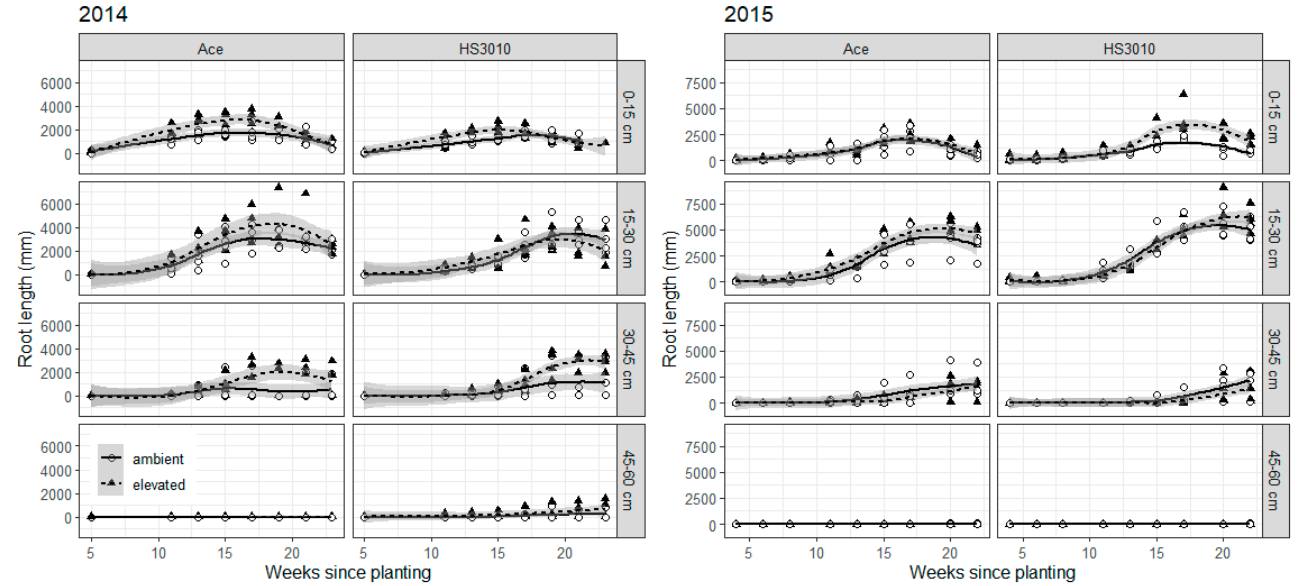
Figure 1. Root length captured by mini-rhizotrons for lentil by [CO 2 ], cultivar and depth in the Australian Grains Free Air CO 2 Enrichment in 2014/2015. A [CO 2 ] by time by depth interaction was significant in 2014 and a [CO 2 ] by cultivar by time by depth interaction was significant in 2015. Flowering occurred at week 17 in both years. Round white circles represent individual sub-plots in ambient main plot and black triangles individual sub-plots in elevated [CO 2 ] main plots. Grayed areas are the calculated confidence interval for treatment means as calculated by the ggplot2 R package. Symbols may be drawn on top of one another.